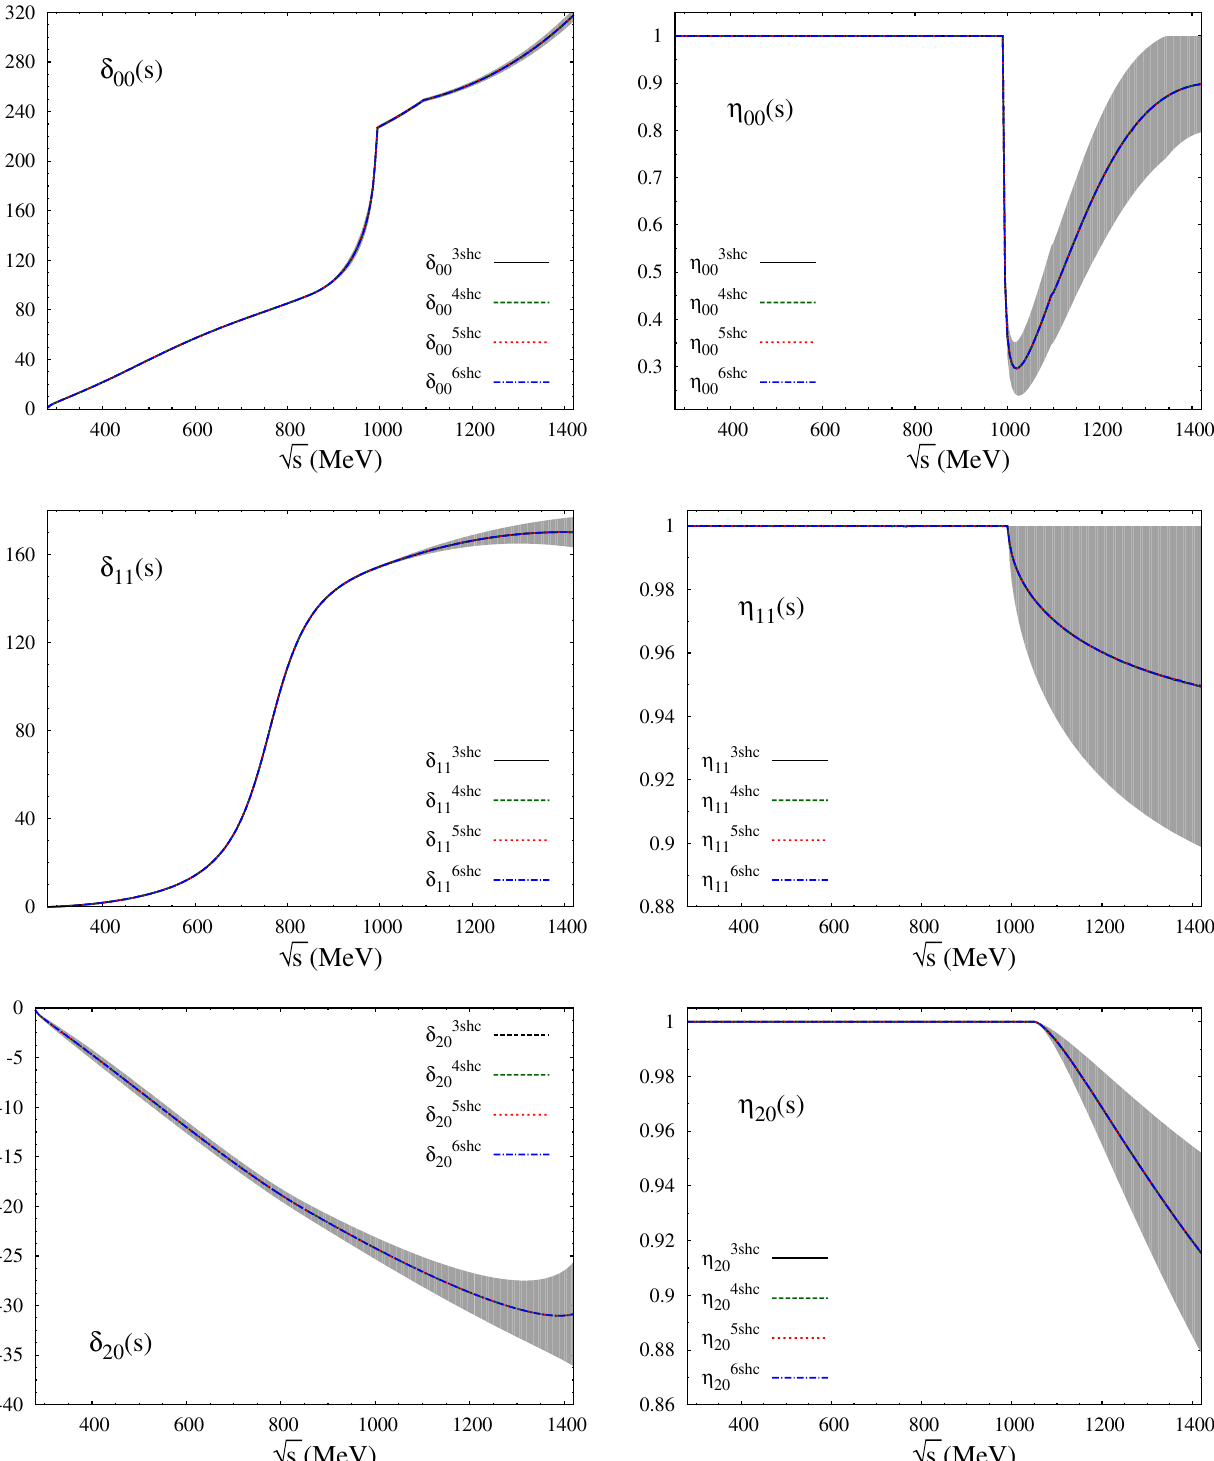
Fig. 11 S0-,P-andS2-wavephaseshifts(leftpanels)andinelasticities (right panels). The uncertainties are those quoted in [22], whereas solid- black, green-dashed, red-dotted and blue dot-dashed lines stand for the